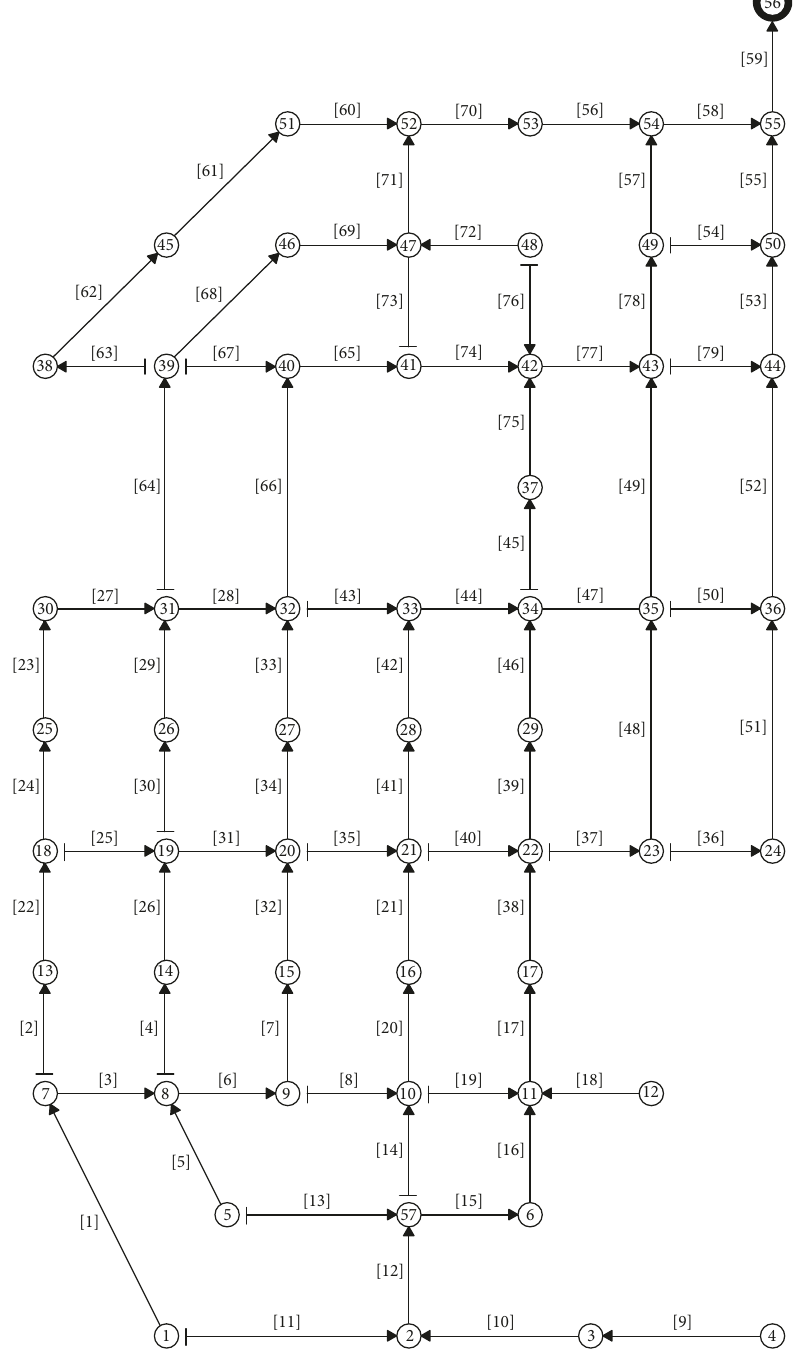
Figure 7: Consequence